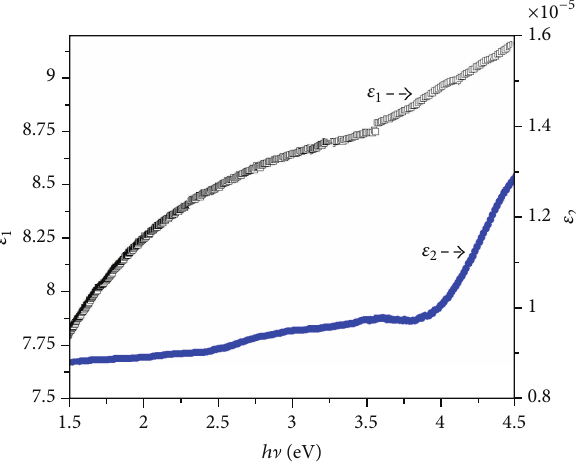
Figure 8: Variation of complex dielectric constants 𝜀 1 and 𝜀 2 with photon